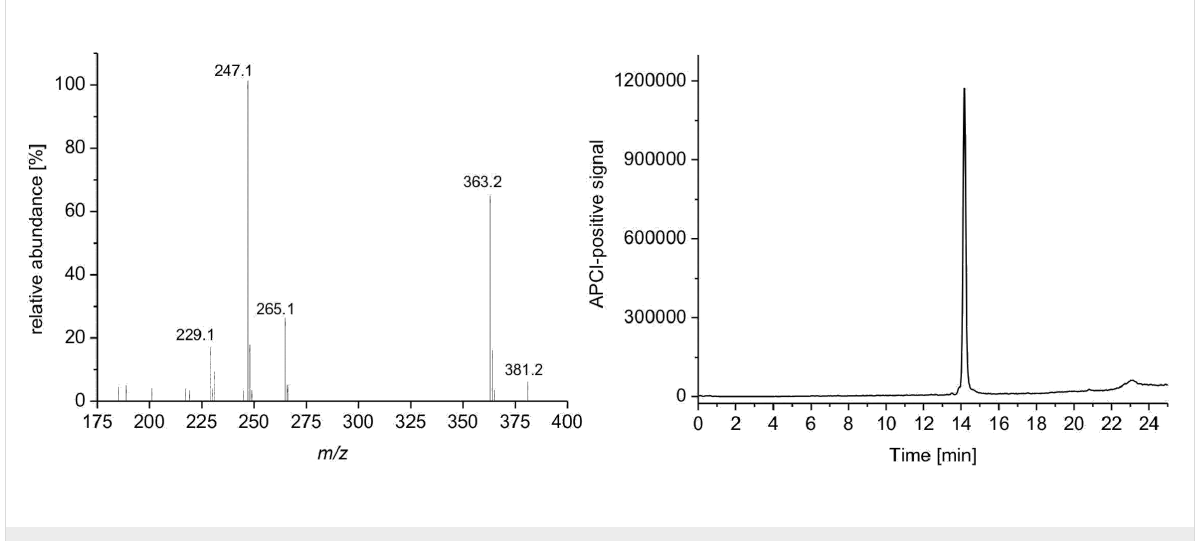
Figure 7: Single-quadrupole mass spectrumof SF002-96-1 obtained using an atmospheric pressure chemical ionization interface showing the pseudo-molecular ion. HPLC–MS analysis of the purified compound (APCI, total ion current).